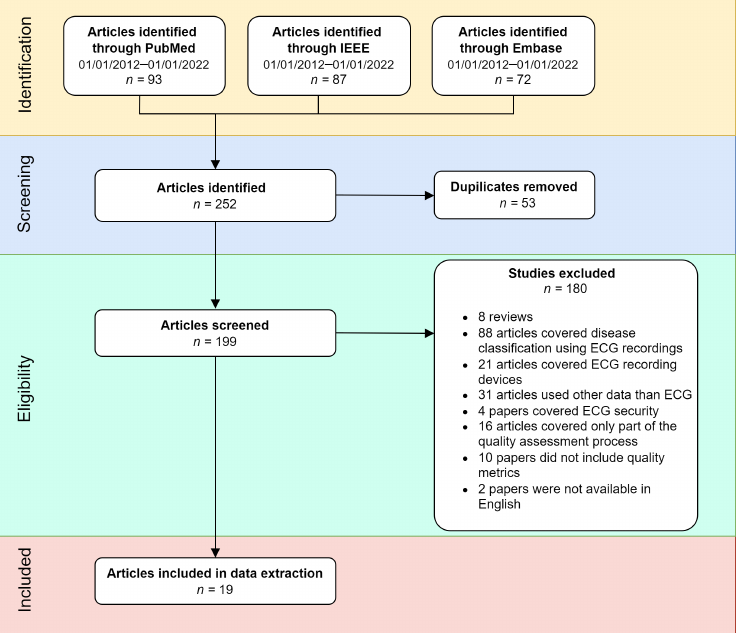
Figure 1. Flow diagram of the review methodology. From the initial search, a total of 252 studies were identified; of these, 53 studies were duplicates, 180 studies were excluded, and 19 studies were included in the